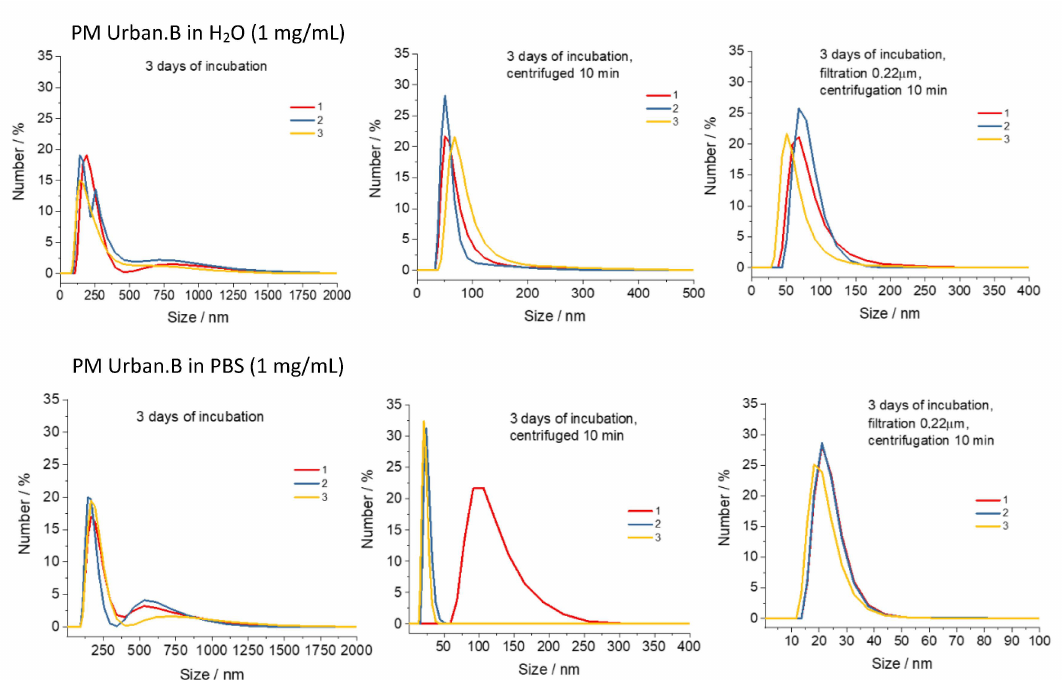
Figure 8. The particle size of Krak ó w particulate matter in water and PBS after preparation using different procedures. Each sample has been analyzed in